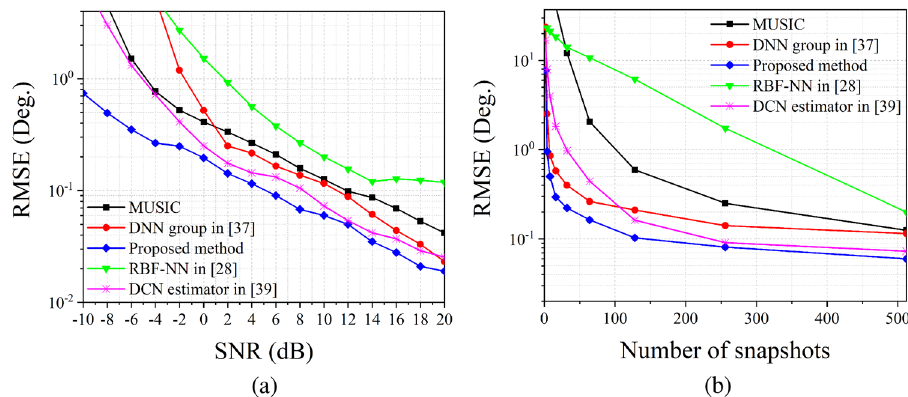
Figure 7. RMSE versus number of snapshots N , SNR equals to 10 dB.